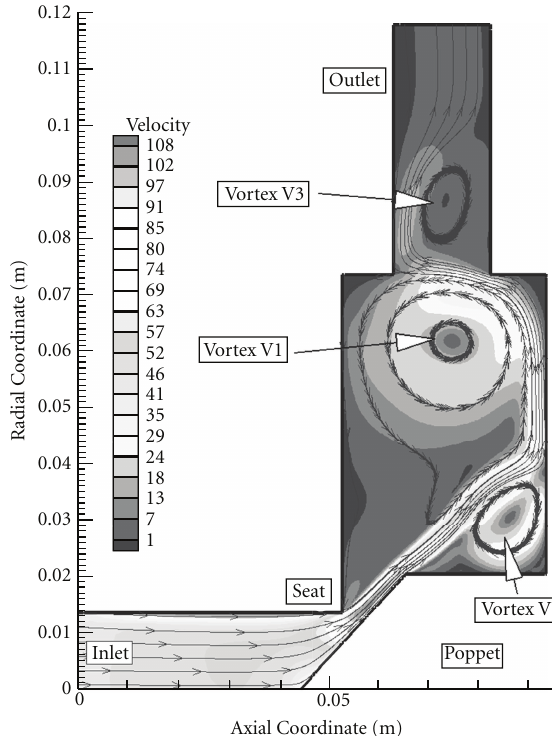
Figure 8: Streamline pattern and pressure field in the meridian half-plane of the poppet valve.